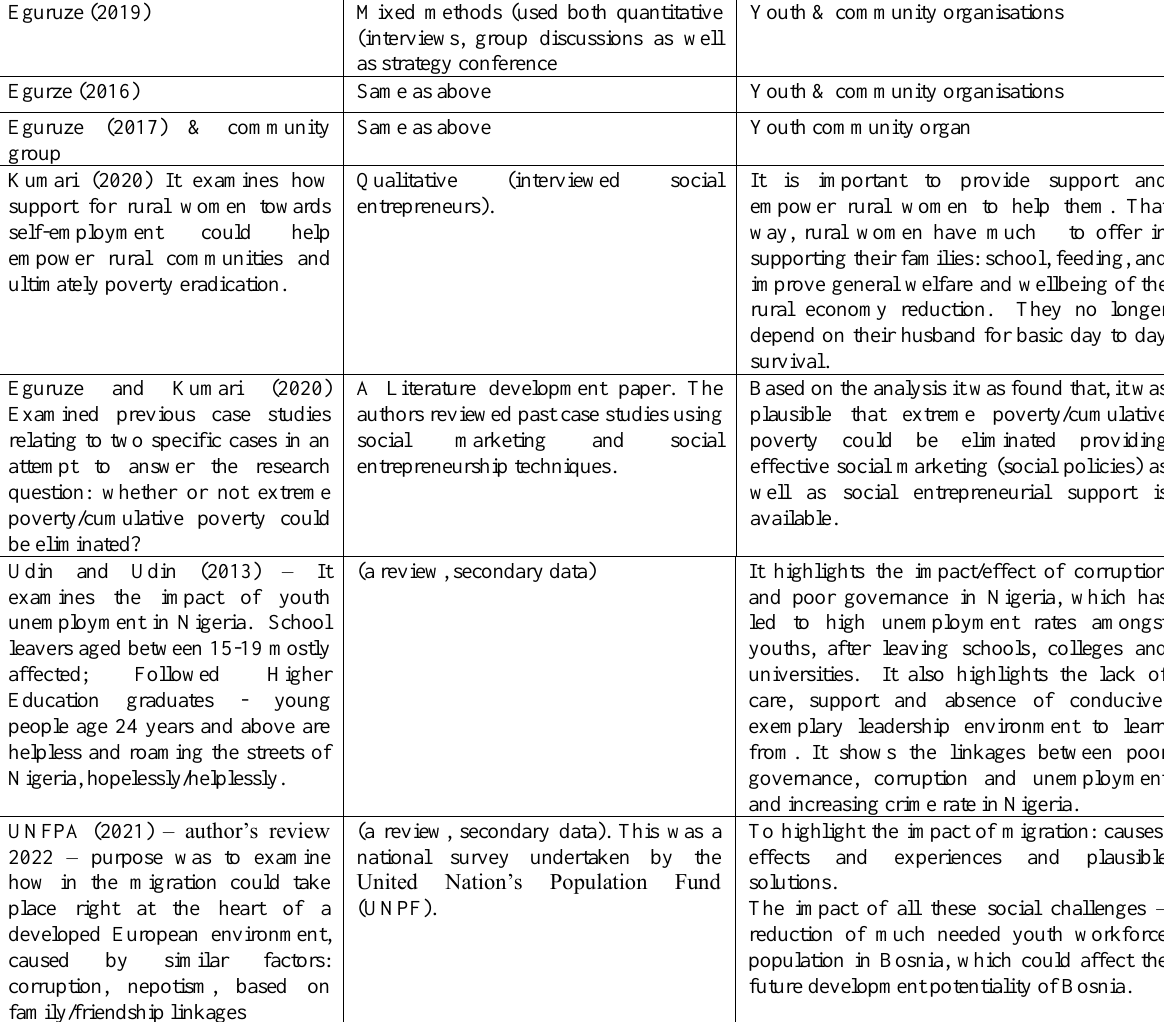
Table 2 (cont.). Highlighting the Differences Between the Previous Studies and Current